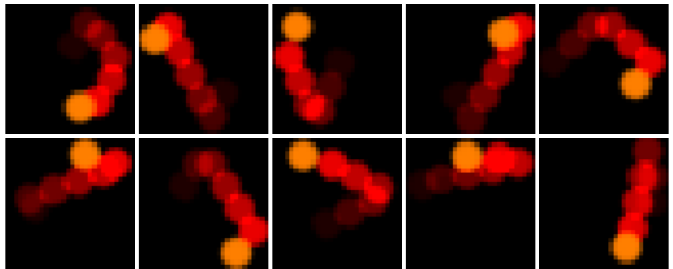
Figure 5. A few samples from the second testing set of the bouncing balls task. The sequence of frames was superimposed here into a single one. The red circles indicate input to the CNN (only every fourth frame is represented, more transparent red circles correspond to earlier frames in the sequence) and the orange one indicates the expected ground truth prediction. Note that every orange circle here is a result of hitting a wall or a corner.